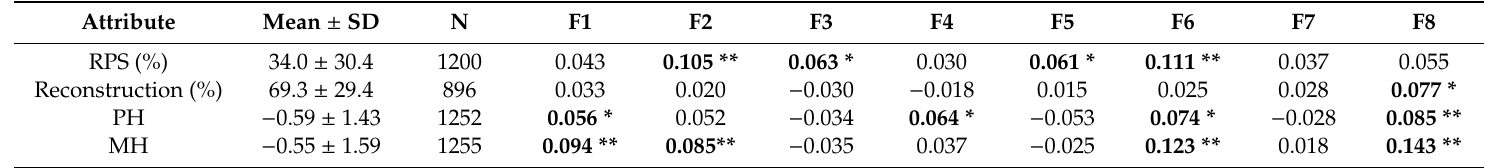
Table 3. External validity of short-form Power to Live with Disasters data with respect to four indices of survival. Data are means and standard deviation (SD) for each survival index, numbers of respondents who provided data, and correlation coe ffi cients. *: p < 0.05, **: p < 0.0063 (Bonferroni-corrected for the number of